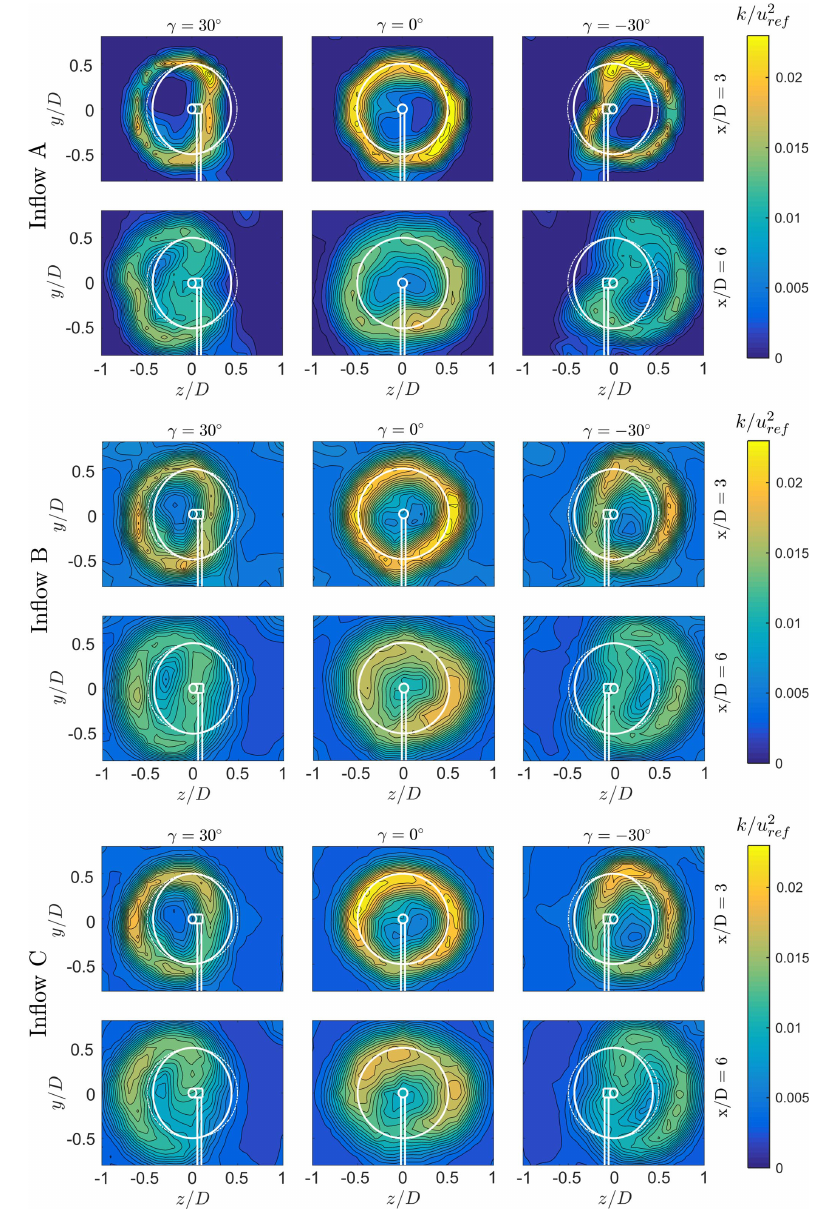
for all measured yaw angles ( γ = − 30, 0 and + 30 ◦ ), downstream distances ( x/D = 3 and 6) and Figure 10. Turbulent kinetic energy k/u 2 ref inflow conditions (A, B, and